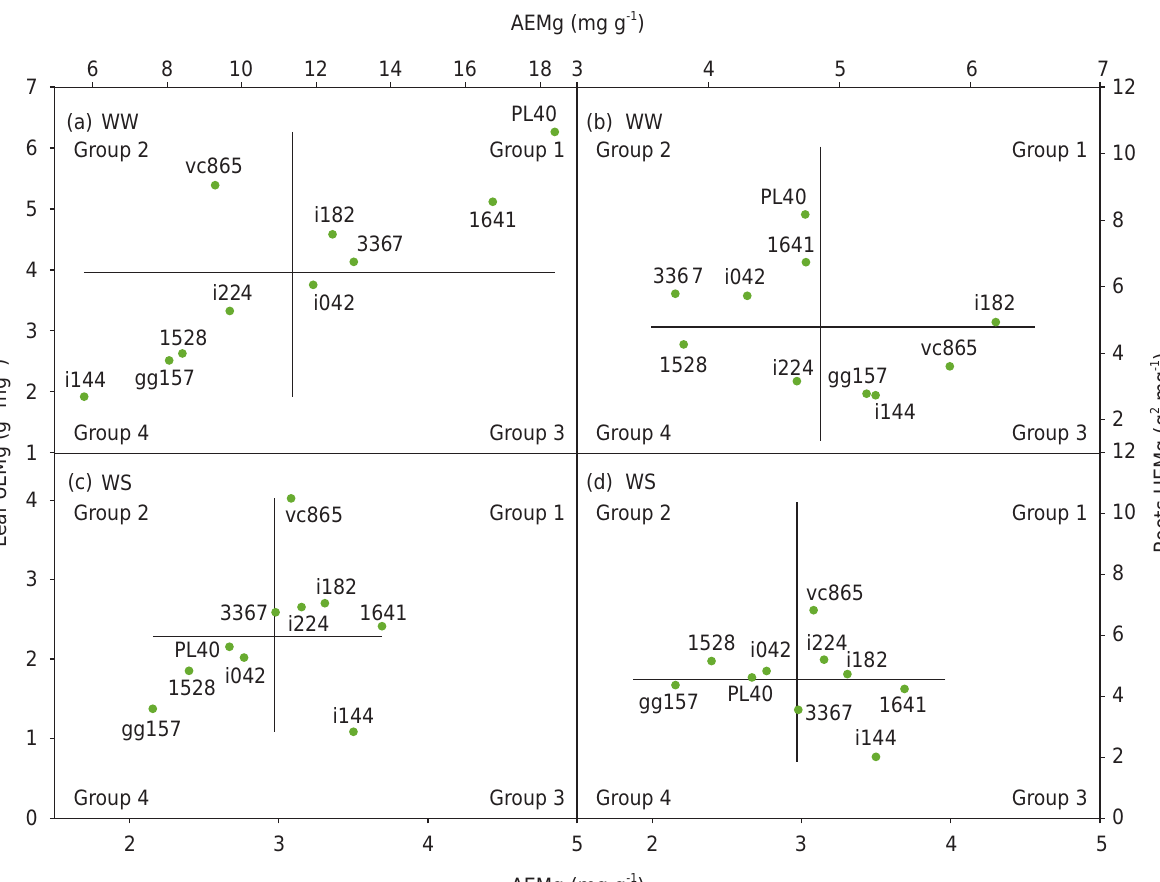
Figure 5. Magnesium absorption efficiency (AEMg) and Mg use efficiency in leaves (leaf UEMg) (a) and roots (root UEMg) (b) of well-watered (WW) plants; and Mg absorption efficiency (AEMg) and Mg use efficiency in leaves (leaf UEMg) (c) and roots (root UEMg) (d) of water-stressed (WS) seedlings of ten Eucalyptus